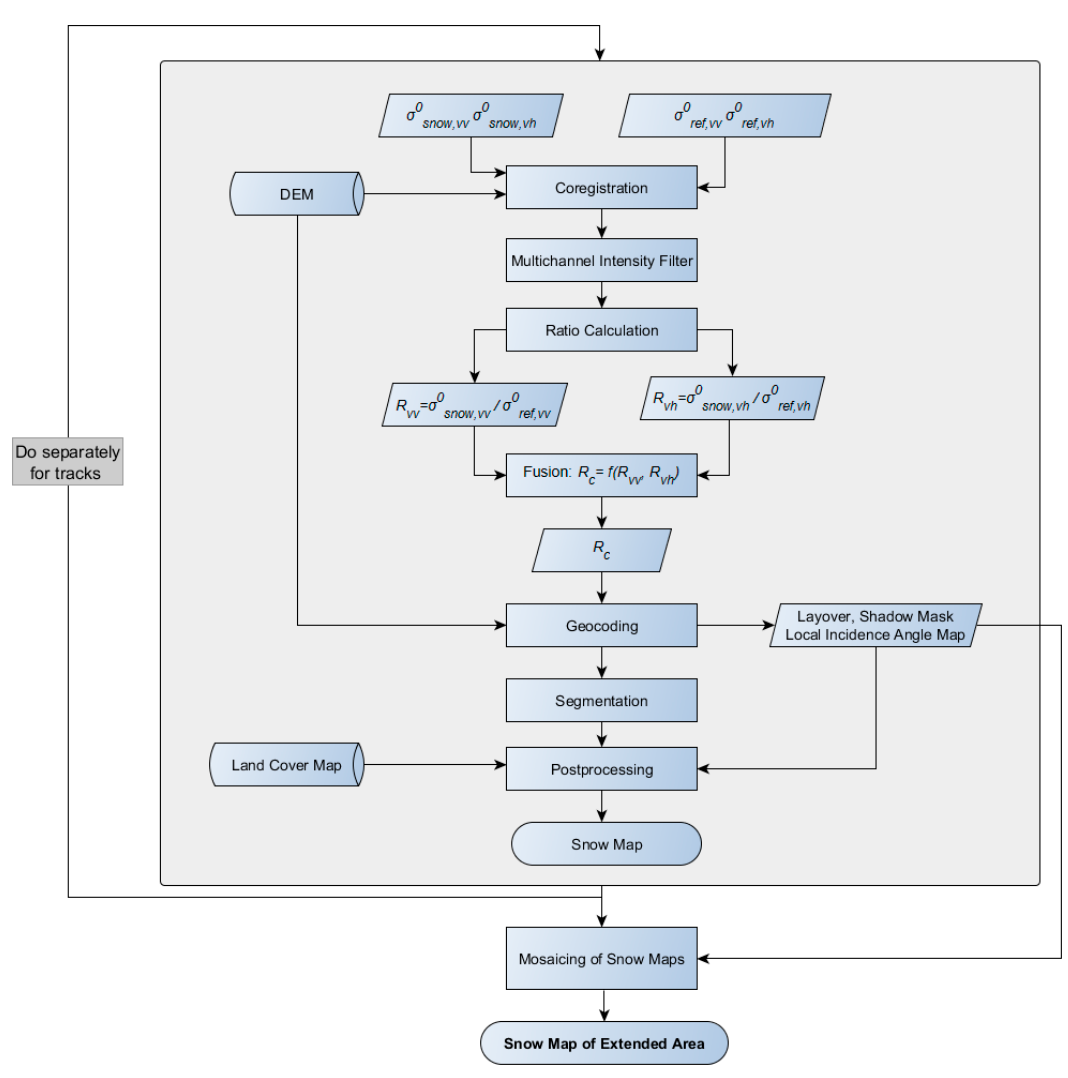
Figure 1. Flow chart of the algorithm for retrieval of snowmelt area from Sentinel-1 Interferometric Wide swath mode data.